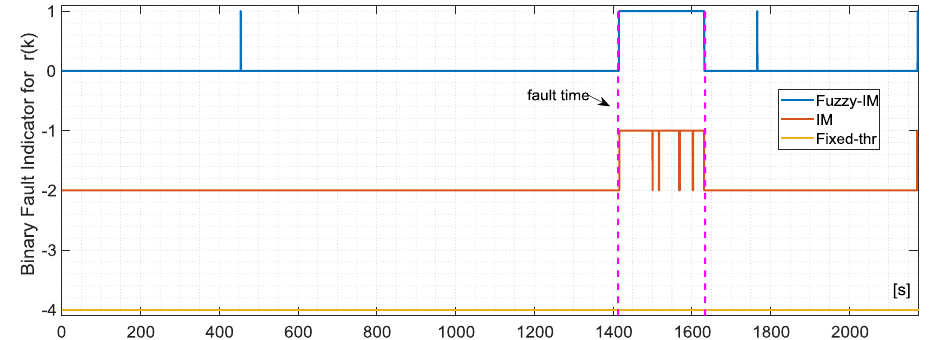
case of validation flight number 1. Sensors 2018 , 18 , x FOR PEER REVIEW 19 of 22